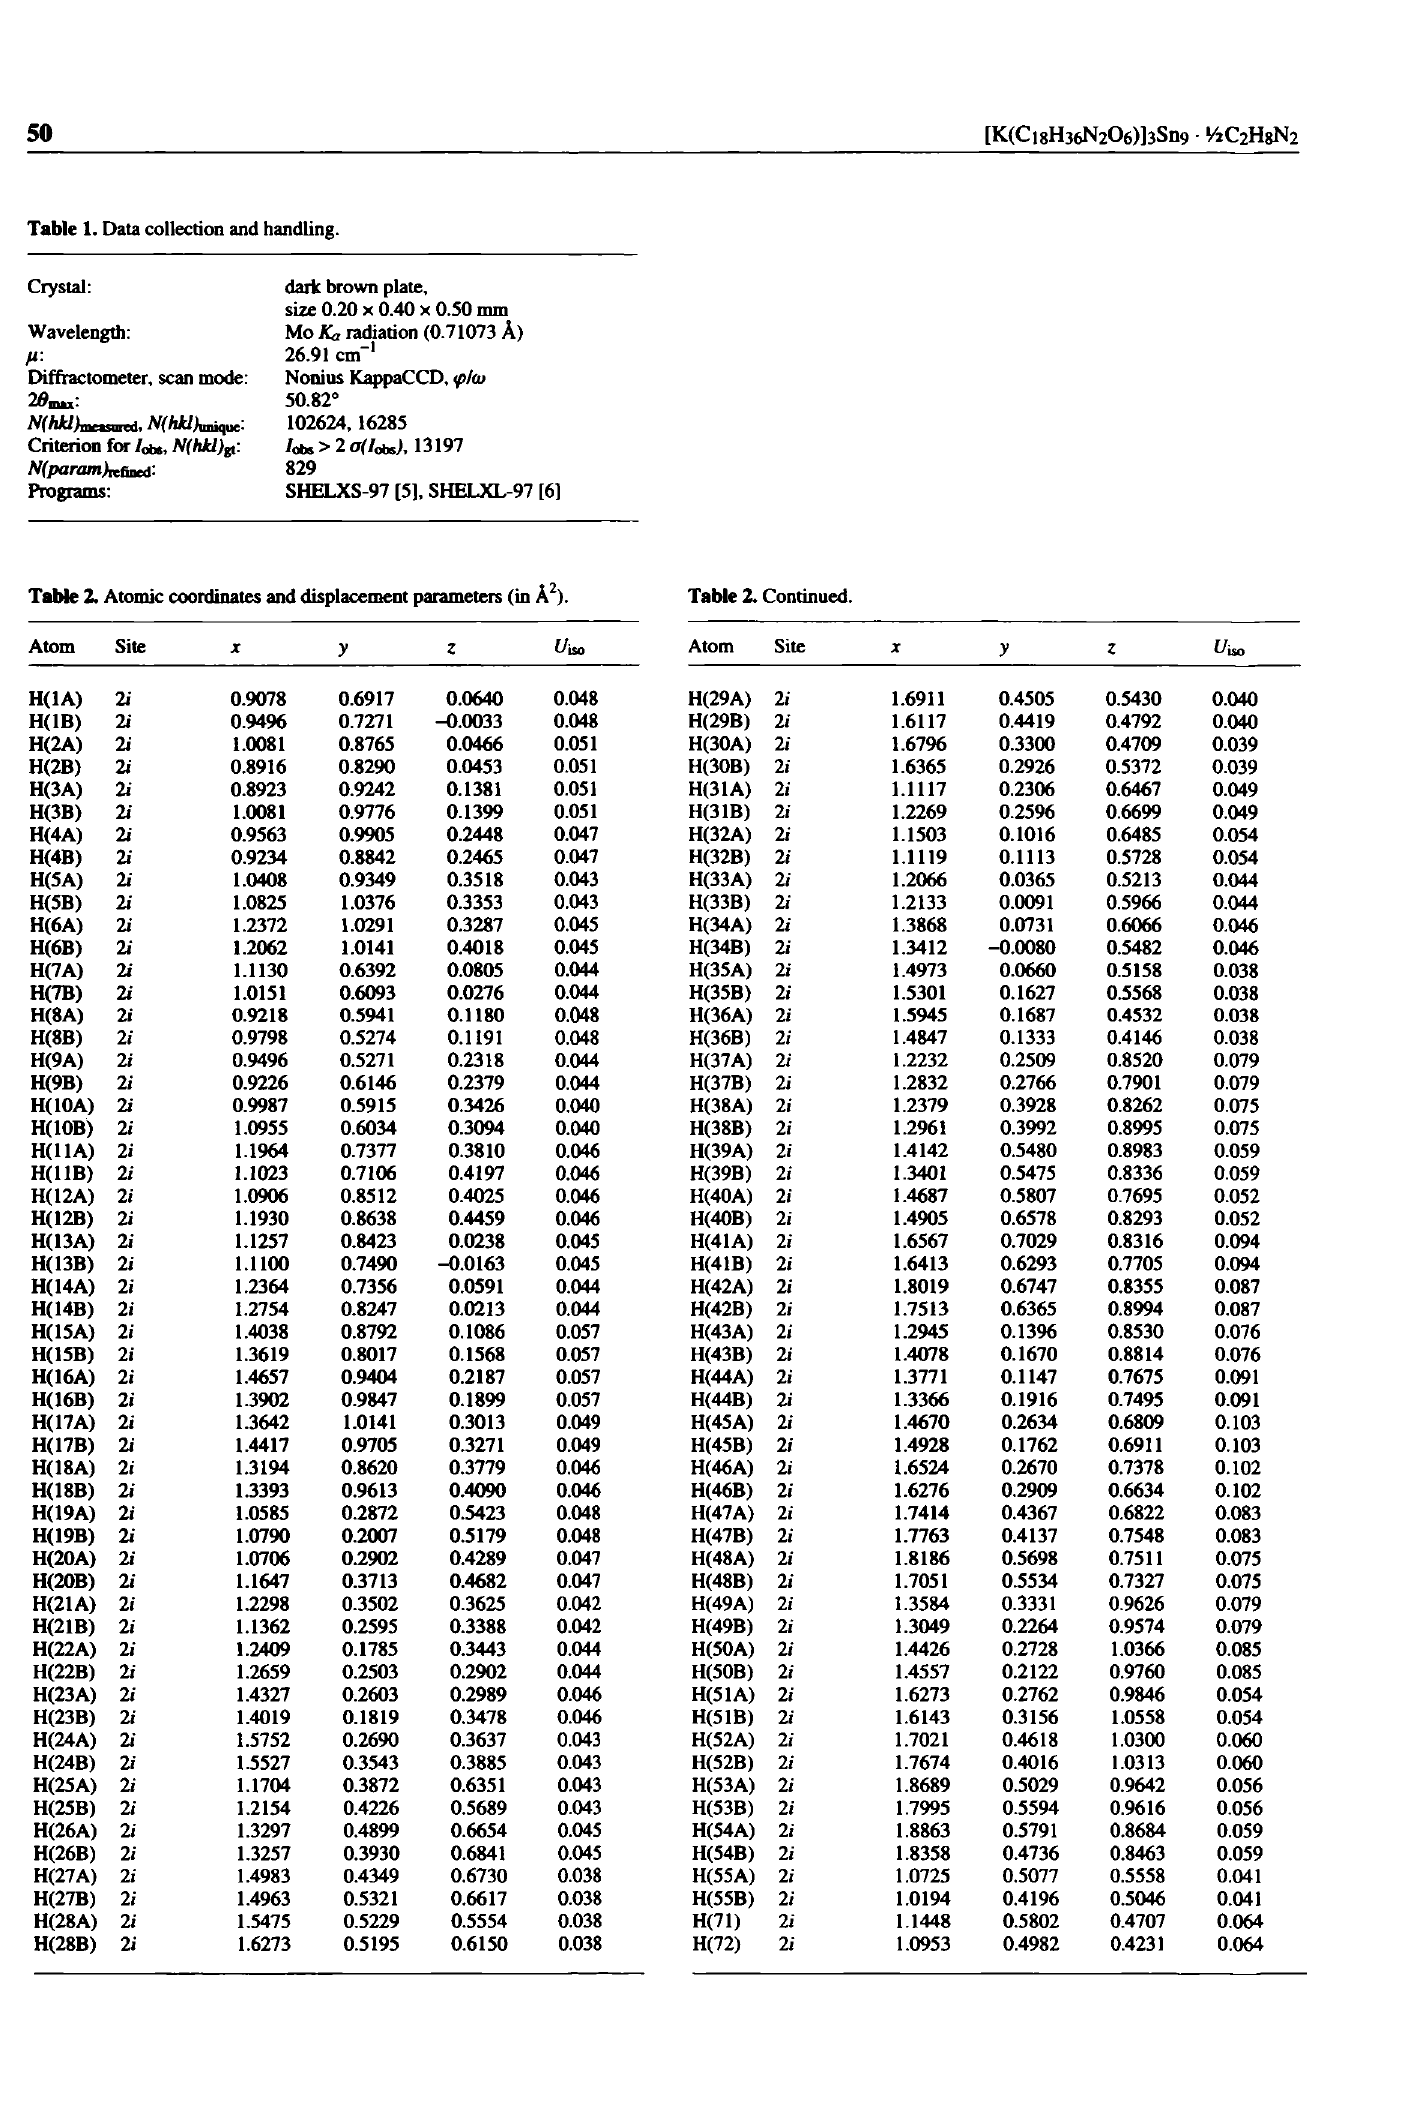
Table 2. Atomic coordinates and displacement parameters (in A 2